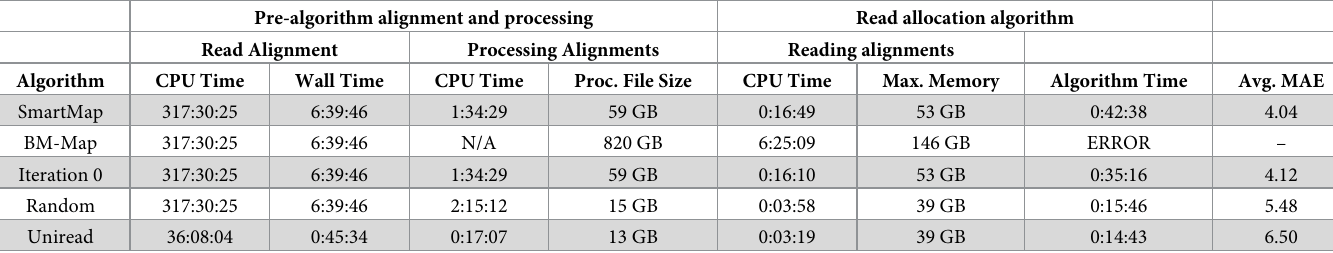
outputs the read depth at each base pair genome-wide or a list of alignments with associated